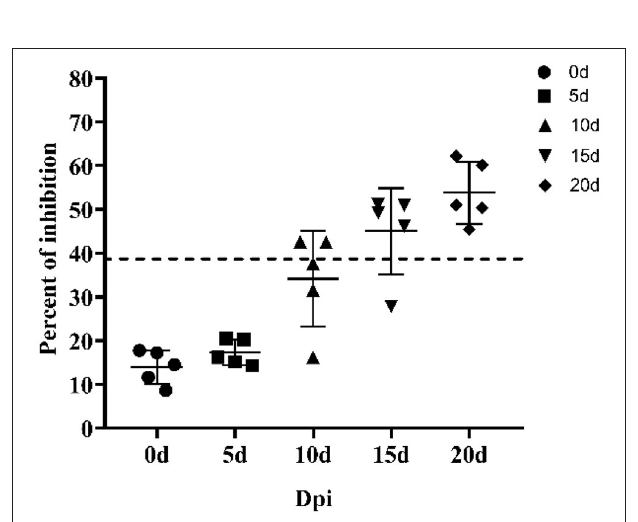
FIGURE 5 | Kinetics of antibody response in serum from ASFV-infected pigs. Serum samples were collected from six pigs infected by ASFV at 0, 5, 10, 15, and 20 days post inoculation. The dashed line represents the cut-off of blocking ELISA.